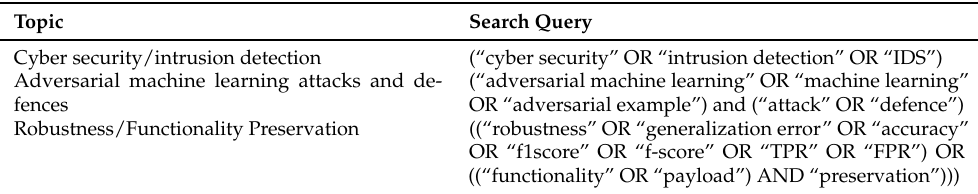
Table 4. Topics and associated search terms used in this